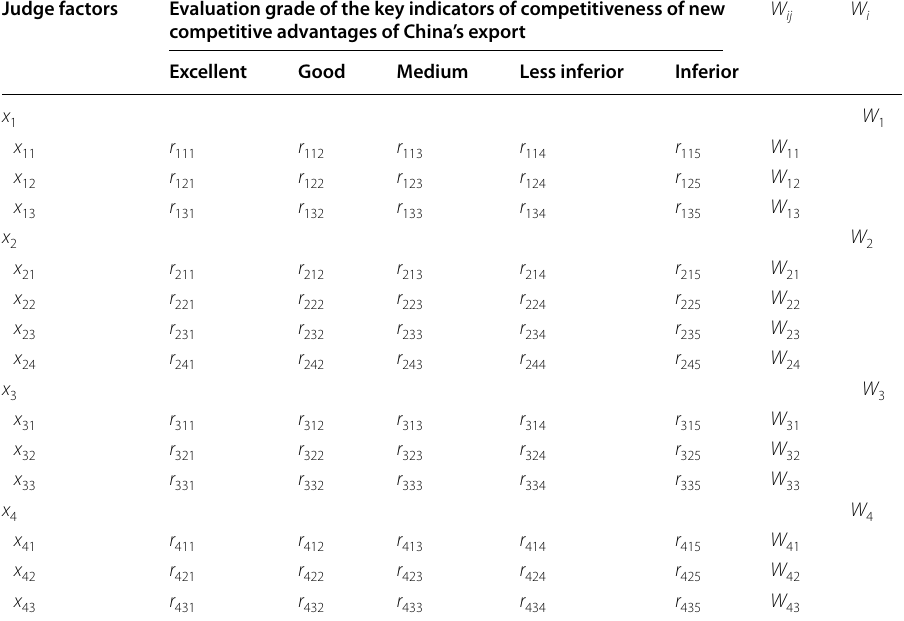
Table 2 Key indicator evaluation table of new competitive advantages of China’s export Judge